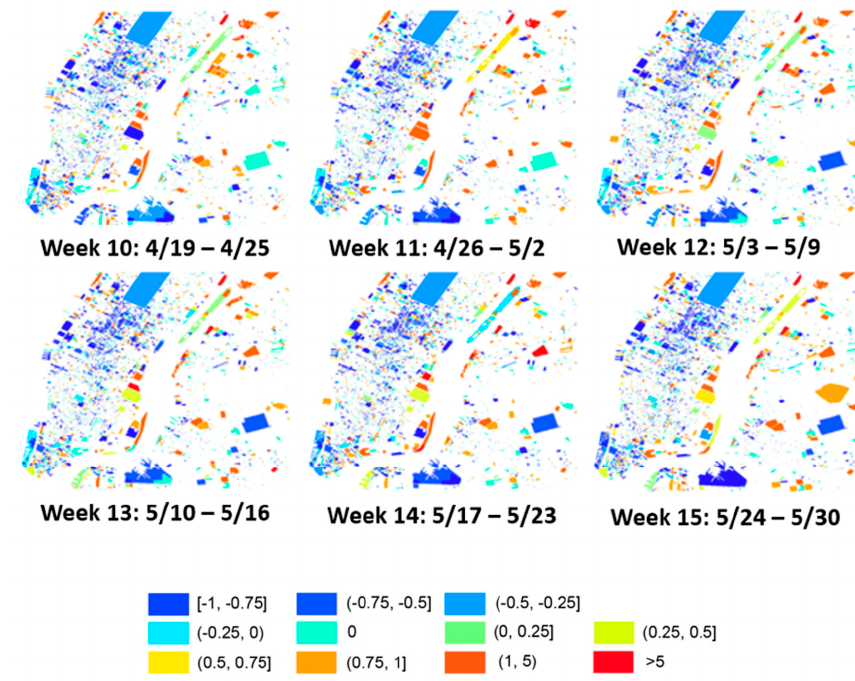
Figure 2. Human mobility changing patterns at parcel-level in weeks 10–15.